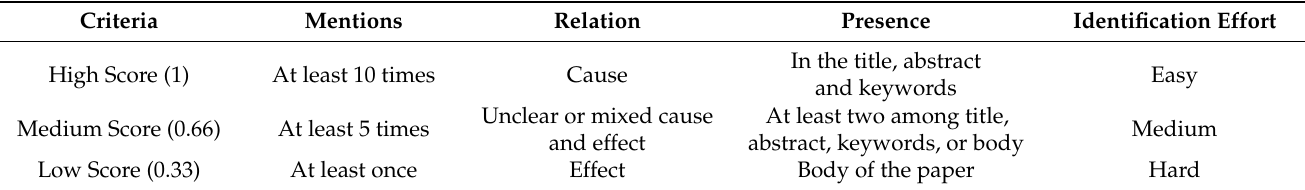
Table 9. Scoring rubric for the critical success